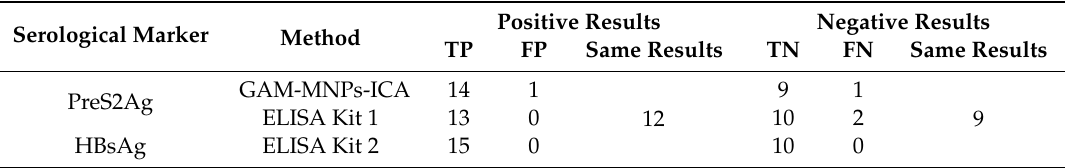
Table 3. Detection results of the clinical serum sample using GAM-MNPs-ICA and 2 types of ELISA kits (n =